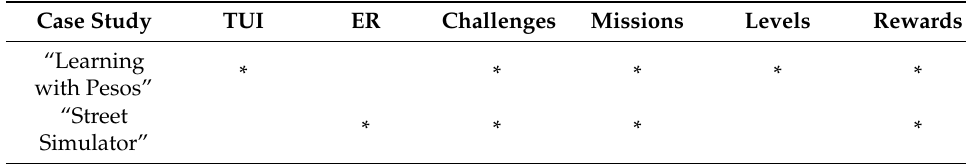
Table 1. Characteristics in common in both case studies.